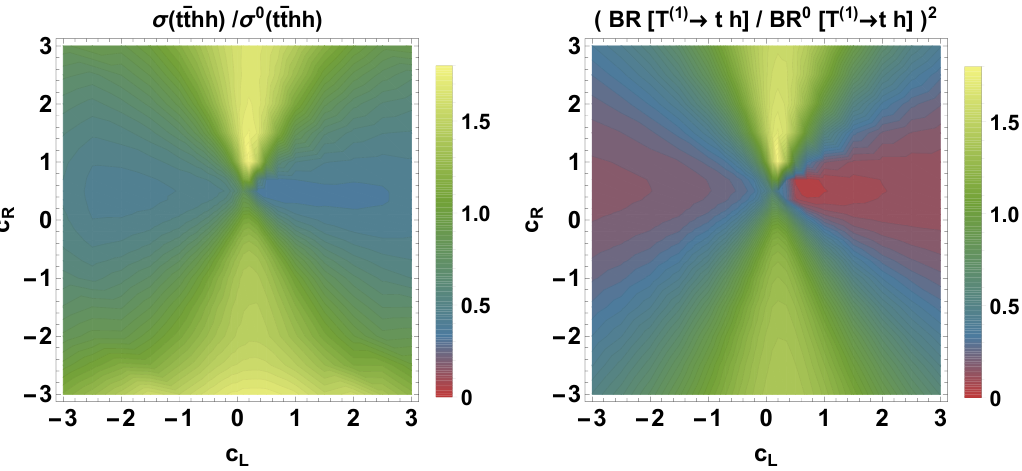
Figure 5 . Variation with c L and c R of the tthh cross section, normalized to the cross section σ 0 ( c R = 0 , c L = 0) , in the MCHM 5 ( M 1 = − 0 . 96 TeV, M 4 = 1 . 4 TeV, f = 1 . 2 TeV, y L = 0 . 88